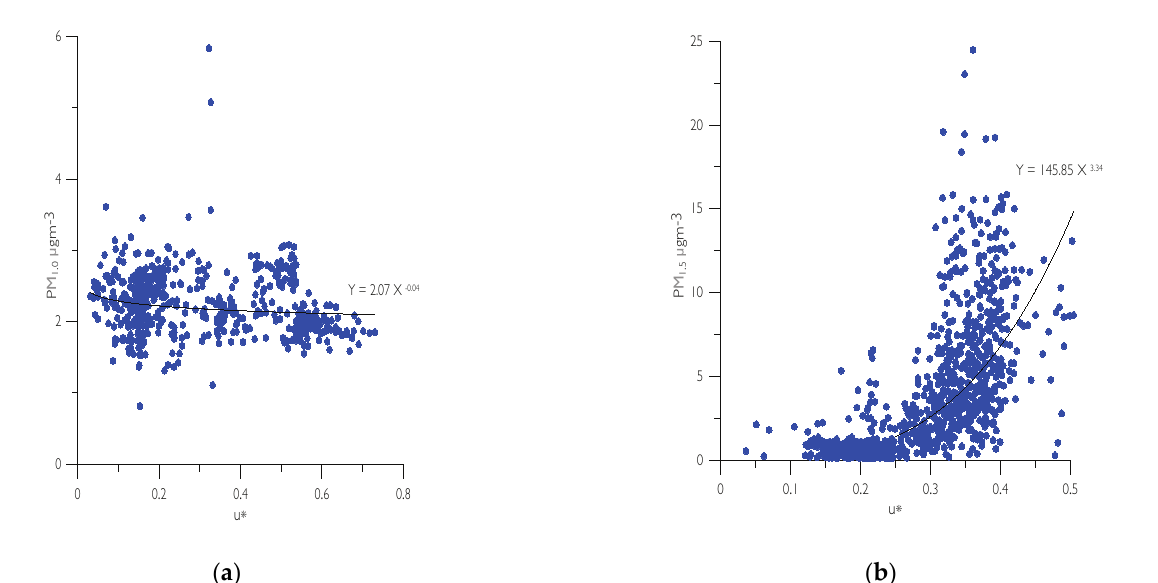
Figure 10. Correlation diagrams between the aerosol mass concentration and the dynamic friction velocity (u*): ( a ) convective mechanism, PM 1.0 for 24 July 2009; ( b ) saltation mechanism, PM 1.5 for 28 July 2011.